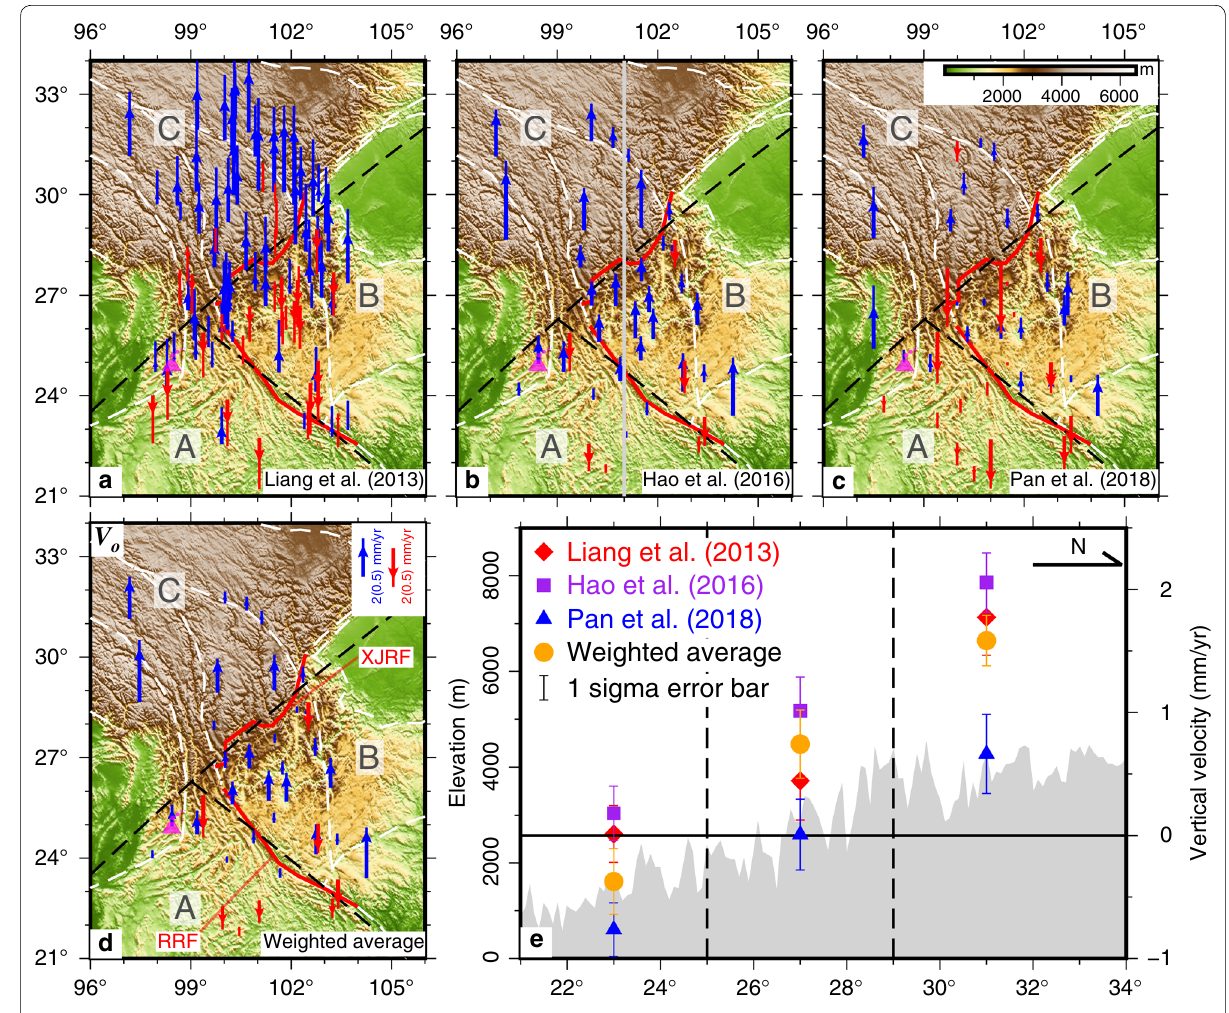
Fig. 2 GPS vertical rates of the Sichuan–Yunnan fragment. Subfigures a , b and c show the results from Hao et al. (2016), Liang et al. (2013), Pan et al. (2018), respectively. d GPS vertical rates of weighted average using the previous datasets in b and c . Blue and red arrows denote the up and down GPS vertical rates, respectively. The northern and southern red lines denote the Xiaojin River fault zone (XJRF) and Red River fault zone (RRF), respectively. The magenta triangle denotes Tengchong volcano field (TCVF). The fault data are from Deng et al. (2003). The black lines crossing the fault zones are dividing the area into three sections: A, B and C shown in the figure. e The symbols with different colors and shapes denote the averages of the vertical rates and standard deviations from different studies. The black line denotes zero value of the rate, and the light gray area denotes the topography along 101° east